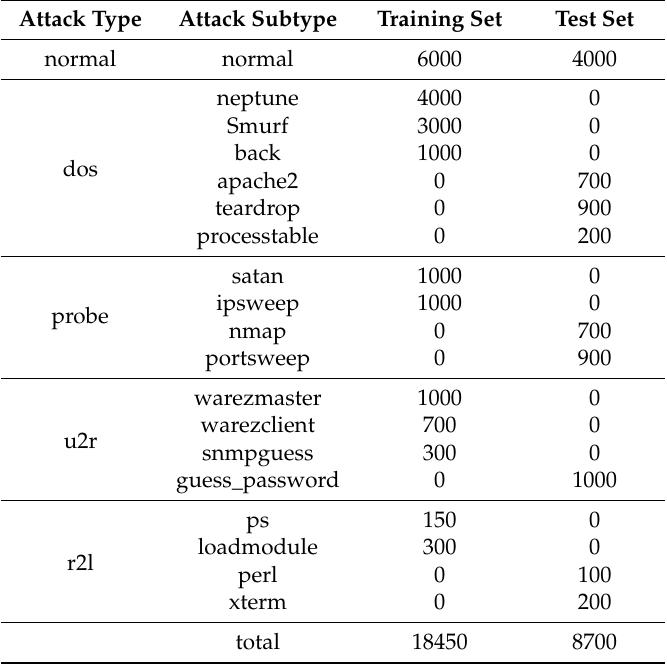
Table A2. Dataset